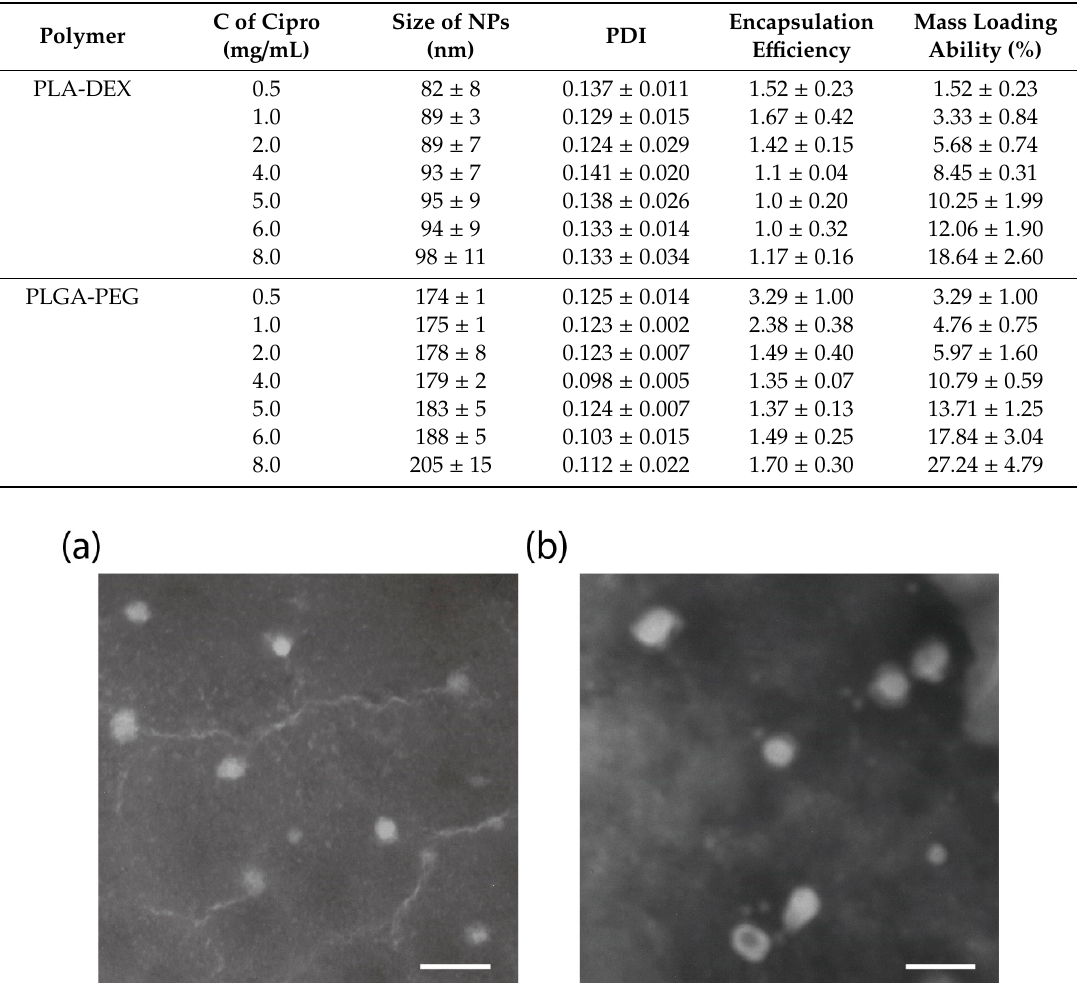
Figure 2. Transmission electron microscopy images demonstrate the spherical shape of ( a ) PLA – DEX NPs and ( b ) PLGA-PEG NPs (Scale bar = 100 nm).